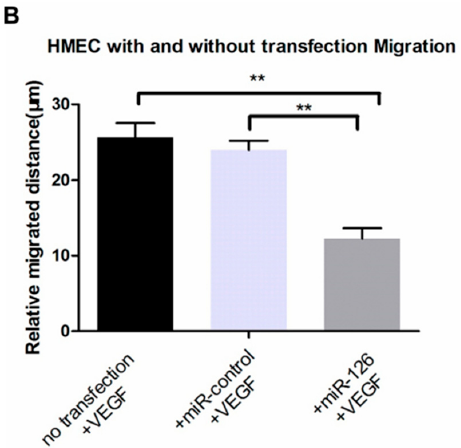
Figure 7. Inhibition of VEGF-induced cell migration by miR-126 overexpression. ( A ) Representative images of HMEC migration in different groups at t = 0 h and t = 9 h; Scale bar = 20 μ m and ( B ) analysis of migrated distance of HMECs with no transfection, transfected miR-control or miR-126 mimic group. Data are present as mean migrated distance ± SD ( n = 4), ** p < 0.01.